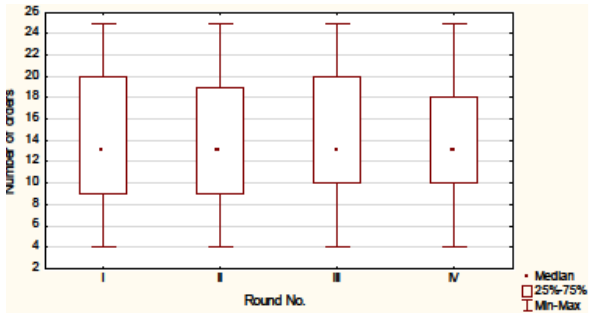
Figure 1: Comparison of the number of orders placed in particular time periods (rounds).